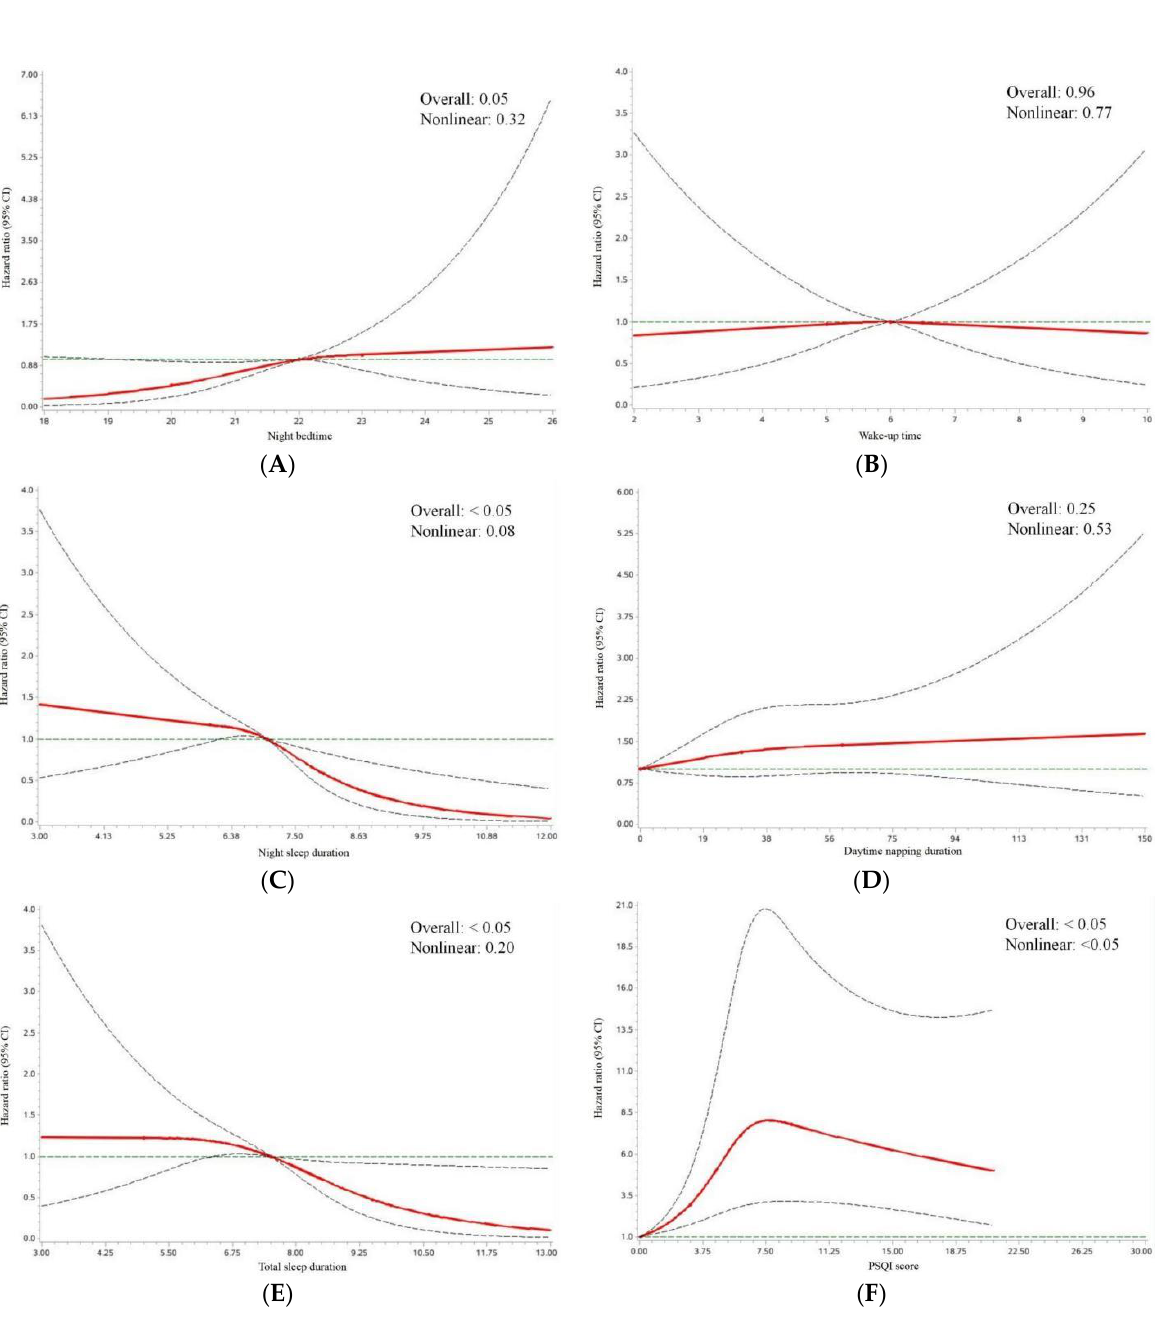
Figure 3. HR and 95% CI of overall survival among ovarian cancer patients by ( A ) night bedtime; ( B ) wake-up time; ( C ) night sleep duration; ( D ) daytime napping duration; ( E ) total sleep duration; ( F ) PSQI score. Multivariable HRs and 95% CIs for overall survival among ovarian cancer patients across strata of various factors. Cox model was adjusted for age at diagnosis, body mass index, physical activity, electronic product use, smoking, alcohol drinking, tea drinking, education level, family income per month, menopausal status, parity, histological type, histopathologic grade, FIGO stage, residual lesions, comorbidities, and rotating night shift work. The red line and dashed line represented the estimated HRs and their 95% CIs, respectively. CI, confidence interval; HR, hazard ratio; PSQI, Pittsburgh sleep quality index.